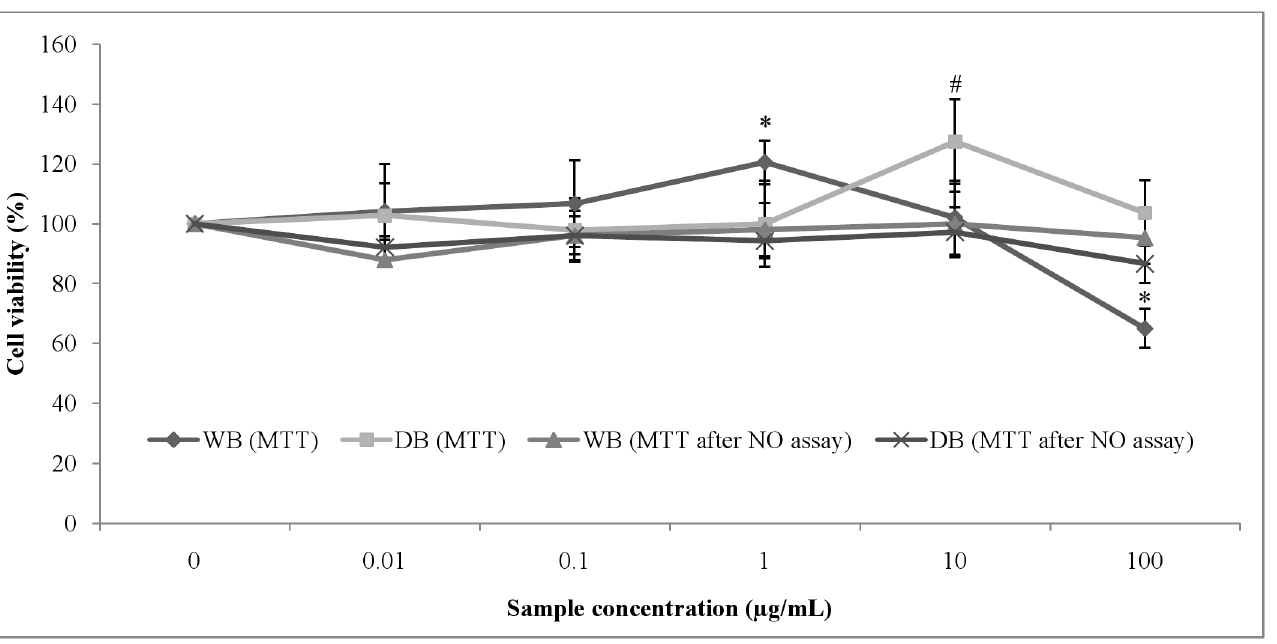
Fig 2. The effects of A . rugosum extracts on RAW264.7 and LPS-stimulated RAW264.7 cell viability (S1 Dataset). RAW264.7 cells were treated with various concentrations of A . rugosum extracts. Besides that, cell viability of LPS-stimulated RAW264.7 cells were also assessed using MTT method.The results shown represent the mean ± SEM, n = 3, and * p < 0.05 compared to negative control (untreated cells or LPS-stimulated cells only) denoted as 100%.